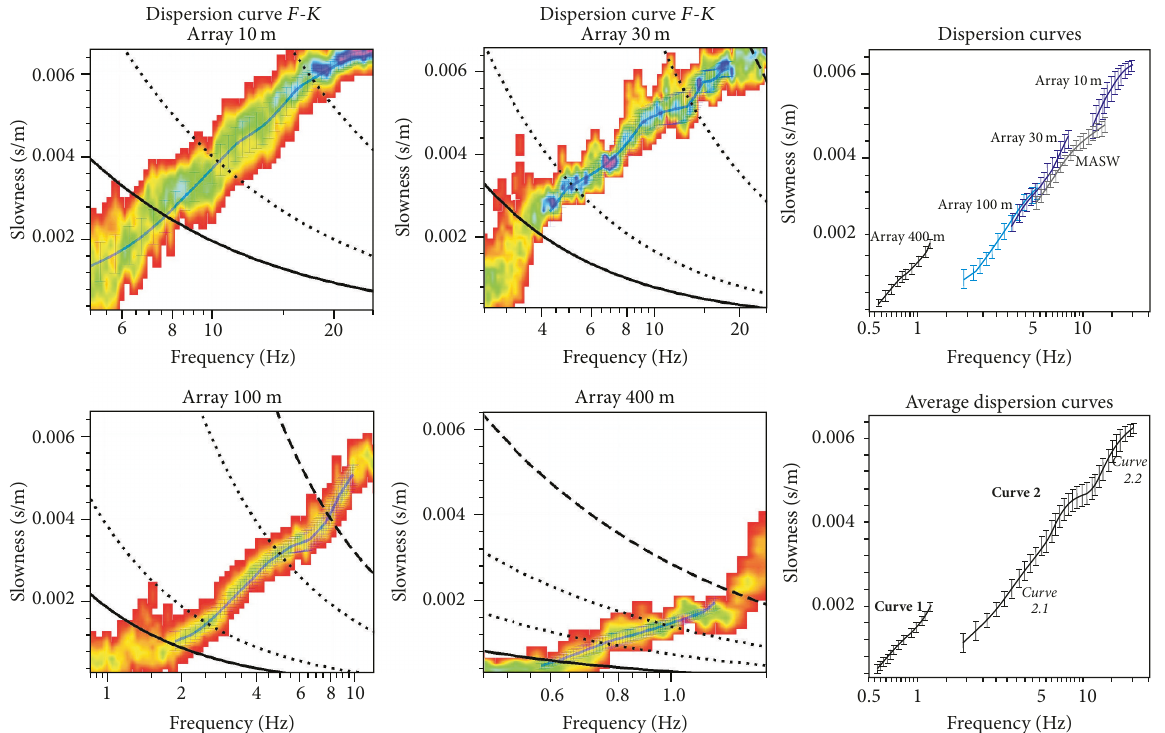
Figure 3: Dispersion curves (slowness versus frequency) obtained using the 𝐹 - 𝐾 method, which considers circular arrays with radii of 10, 30, 100, and 400 m. Dashed lines indicate reliability ranges and the bars in the curves are associated with the dispersion of slowness for each frequency. The right panels show the dispersion curves for different seismic arrays and the solid black line represents the average. measurements distributed in five parallel lines (SW-NE),